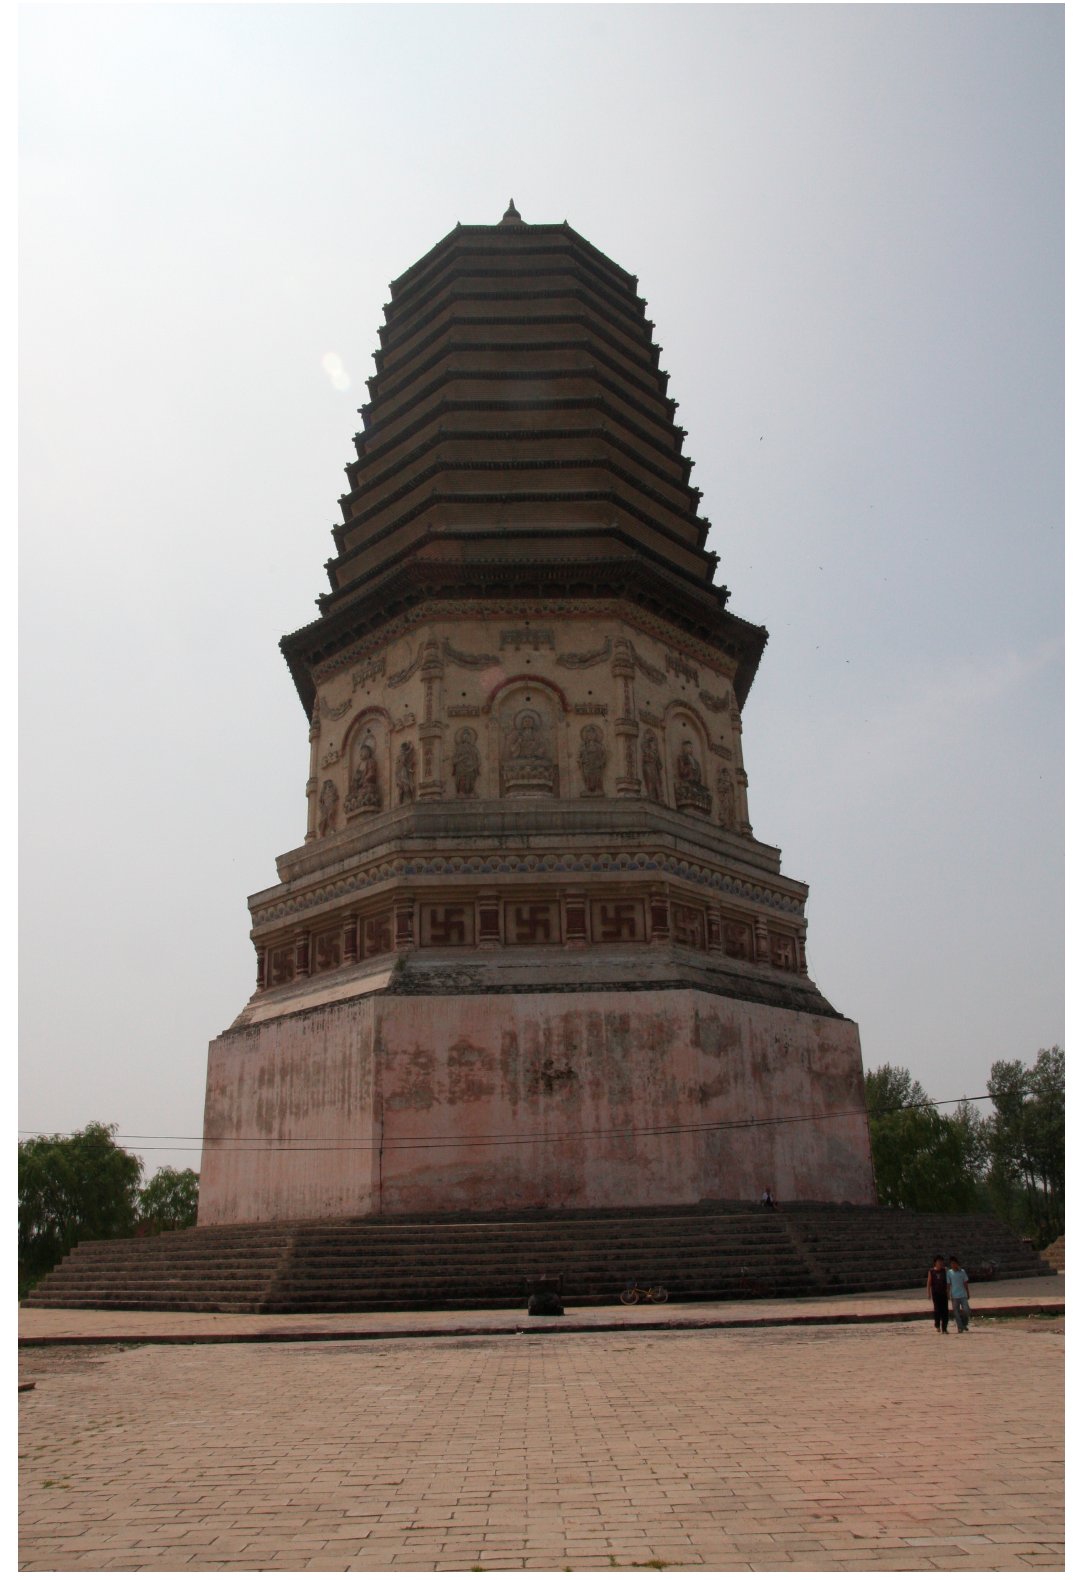
Figure 4. Daming Pagoda, Ningcheng County, Chifeng, Inner Mongolia. Liao dynasty, latter half of the 11th to the early 12th century [©Photograph by Youn-mi Kim, 2009].